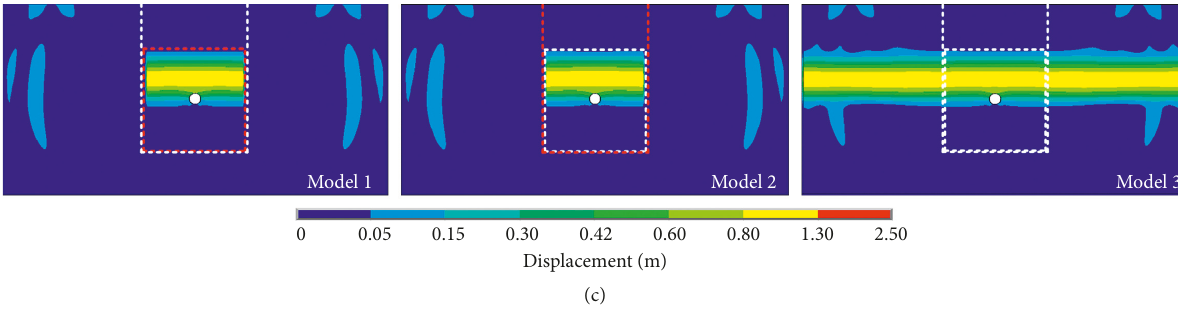
Figure 6: Snapshots of the homogeneous half-space model with an underground cavity: (a) t � 0.46s, (b) t � 0.60s, and (c) t � 0.80 s.